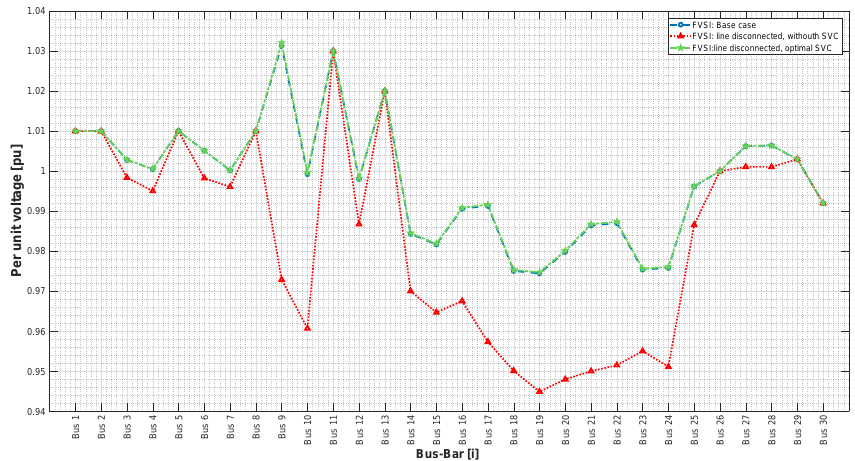
Figure 16. Second study case: Voltage profiles before/after contingencies and with SVC compensation, when the line that contains the node for the optimal solution is